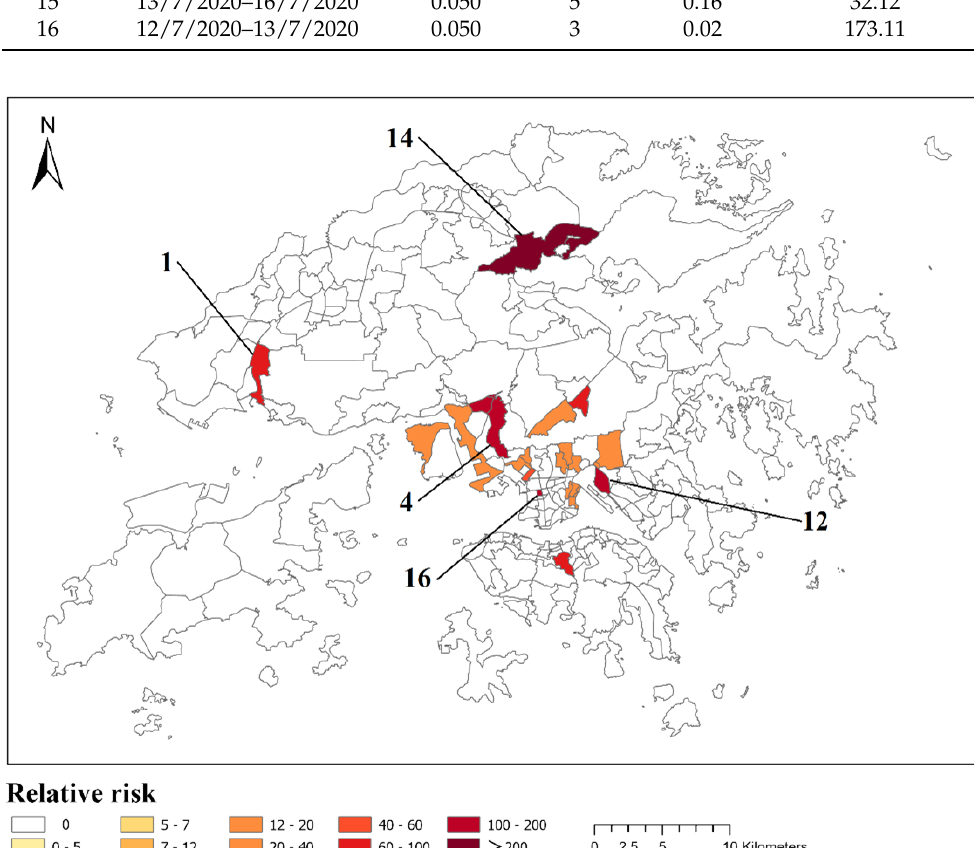
Figure 6. Space–time cluster distribution in Stage II at residential locations (In which number 1, 4, 12, 14, 16 indicate the most significant clusters) .